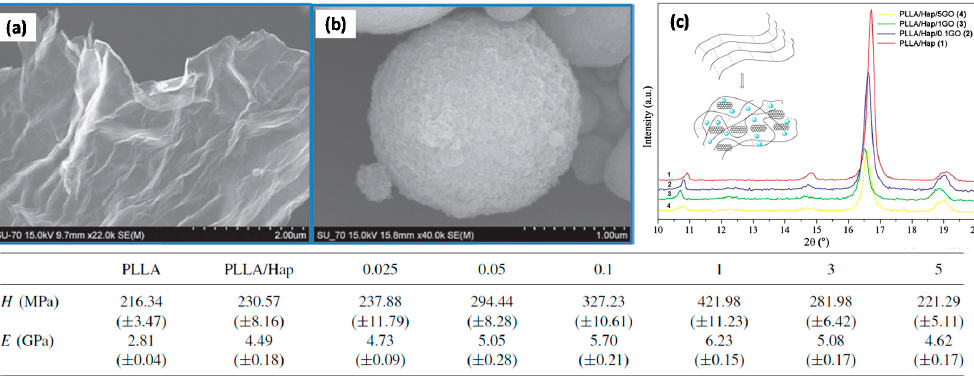
Figure 18. SEM images of ( a ) graphene oxide and ( b ) hydroxyapatide; ( c ) X-ray diffraction patterns of PLLA/Hap and PLLA/Hap with 0.1, 1, and 5% of GO. Inset: schematic representation of polymer chains with and without Hap and GO fillers. The table shows hardness and elastic modulus values of PLLA, PLLA/Hap, and PLLA/Hap with different GO percentages, measured by nano-indentation [76]. Bao et al. [77] produced graphene from graphite by pressurized oxidation and multiplex reduction. They executed this pressurized oxidation process with multiplex reduction based on ammonia and hydrazine and produced single-atom-thick graphene (0.4–0.6 nm thick; see Figure 19a).